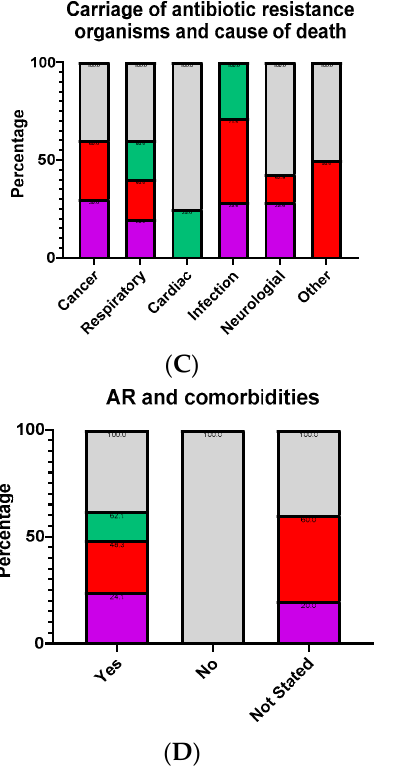
Figure 5. Antibiotic resistance carriage in respect to other factors. The figures show the distribution of antibiotic resistant organisms based on their place of residence ( A ), place of death ( B ), cause of death ( C ) and comorbidities ( D ). This data utilised the set of cadavers (n = 35) with growth of antibiotic resistant bacteria on the pre-embalming plates. The numbers within the segments show the additive proportion from each segment and those below it.